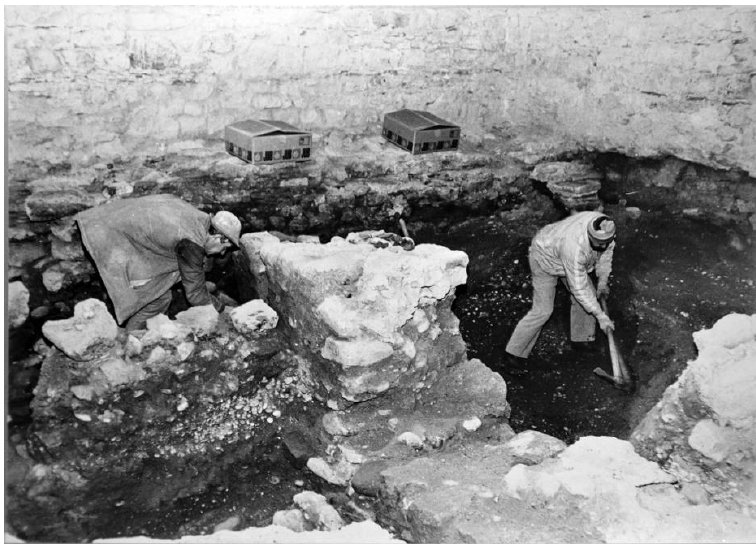
Figure 7. Unearthing of the wall foundations lying north–south, forming the western wall of a smaller building, probably the oldest synagogue phase. Interior. Photo: The Maribor Regional Office of the IPCHS, Fond Maribor—Sinagoga.